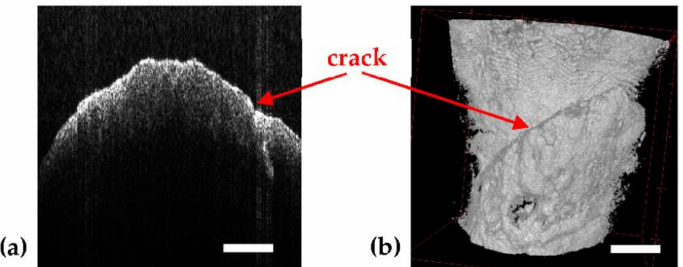
Figure 3. Example of a single OCT B-scan/optical cross section ( a ) and the corresponding 3D OCT image reconstruction ( b ), showing a crack in a tooth—example of OCT imaging showing the higher resolution capability compared to radiography, as approached in detail in the exploratory study in [28]. Scale: 1